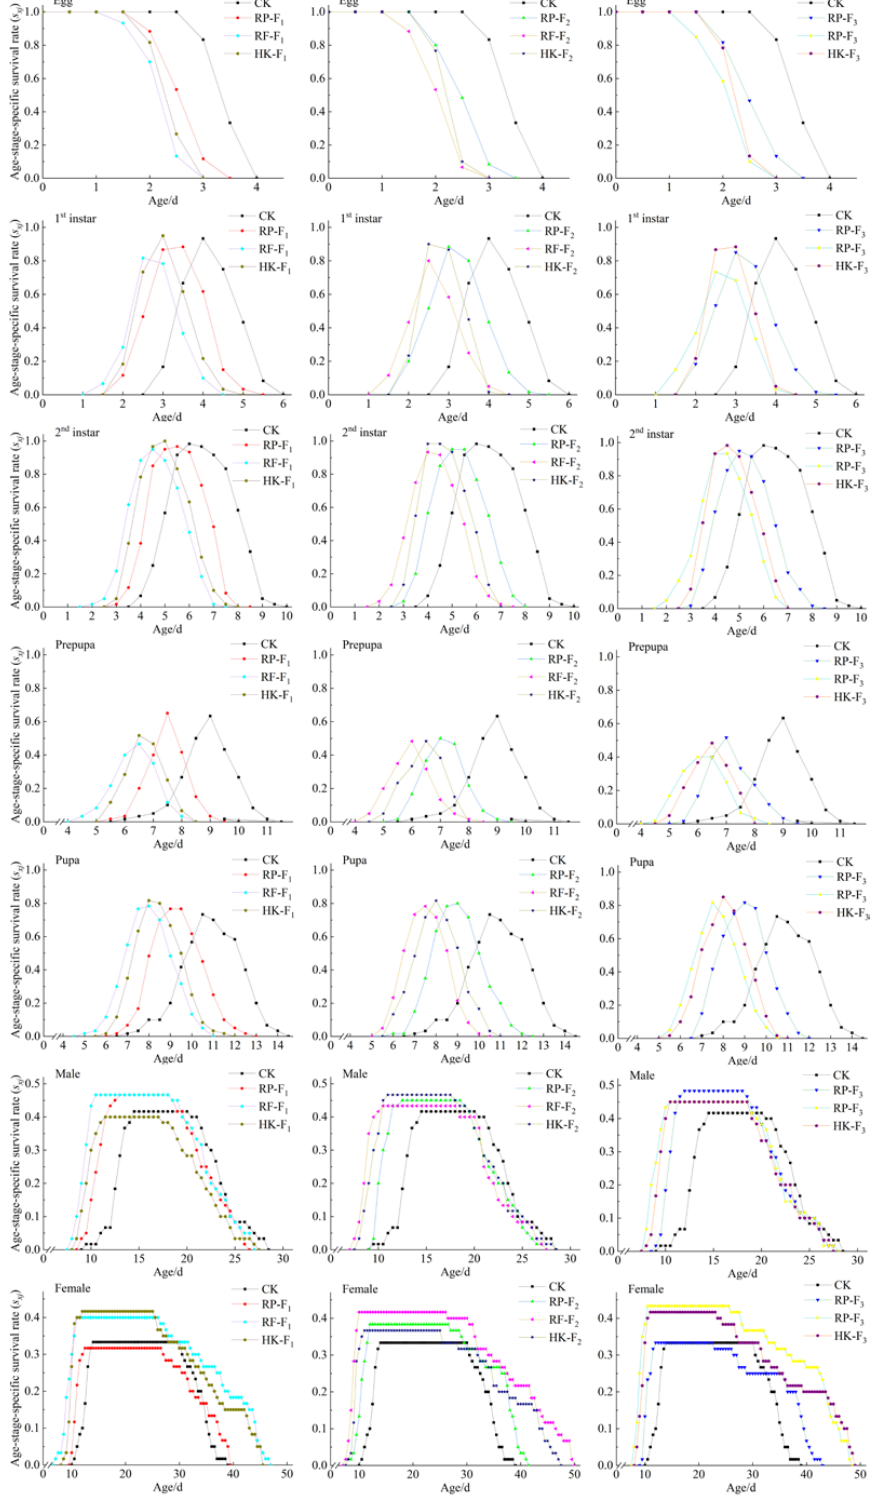
Figure 1. Age-stage specific survival rate ( s xj ) of F. occidentalis fed on rose petals (RP), rose flowers (RF), and 10% honey solution + kidney bean pods (HK) in F 1 , F 2 , and F 3 generations, and control group F. occidentalis feeding on kidney bean pods